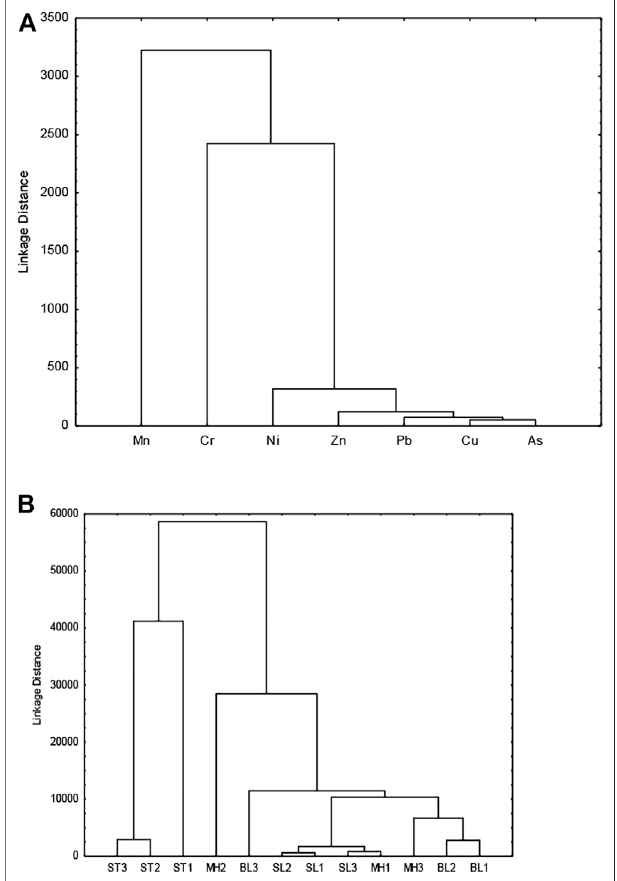
FIGURE2|(A) Clusteranalysisofsedimentfordifferentmetal(loid)sfrom the Blyde, Mohlapitsi, Ga-Selati, and Steelpoort rivers. (B) Cluster analysis of metal(loid)s in the sediments from different sites of the Blyde, Mohlapitsi, Ga- Selati, and Steelpoort rivers.